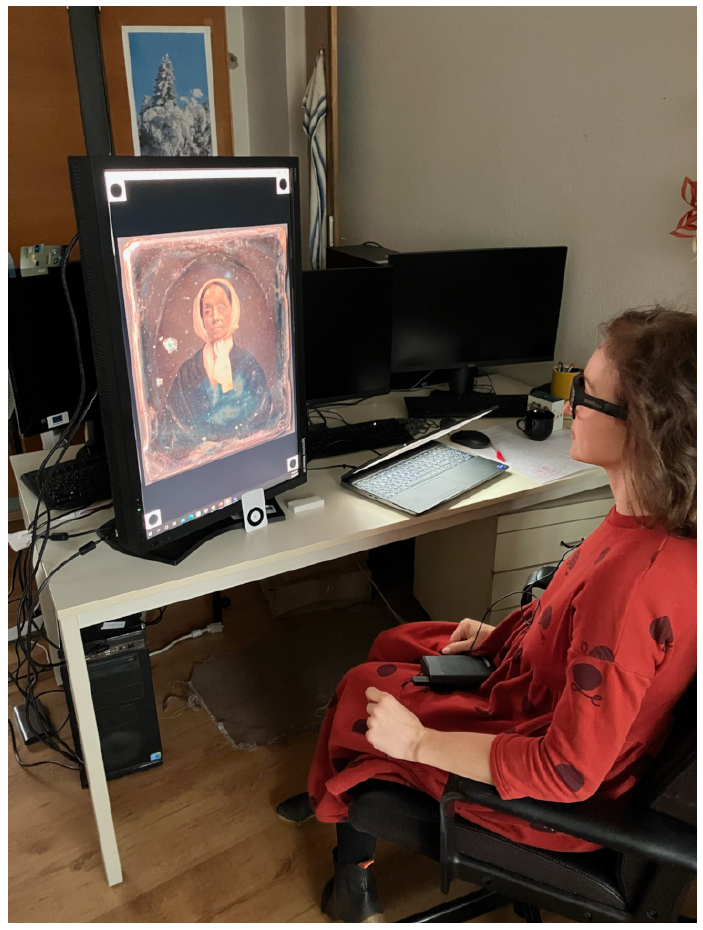
Figure 1. Image of the eye-tracking session at Comenius University. The participant, Zuzana Berger Haladová agrees with the publishing of her photo here. Photo by Zuzana ˇCerneková, 2022.